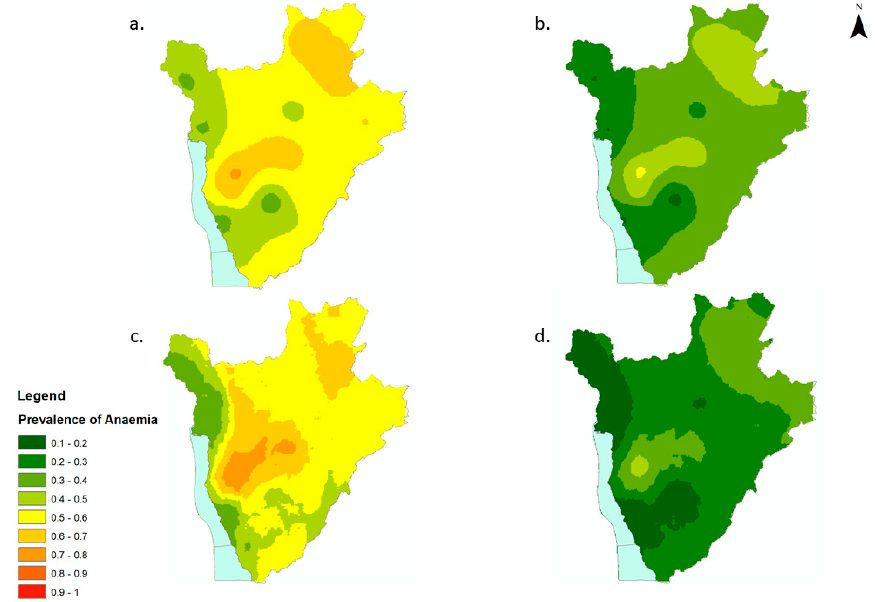
Figure 1. Predicted prevalence maps of anaemia per year for school-aged children (5–15 yrs) in Burundi, 2008–2011. ( a ) 2008, ( b ) 2009, ( c ) 2010, ( d ) 2011.